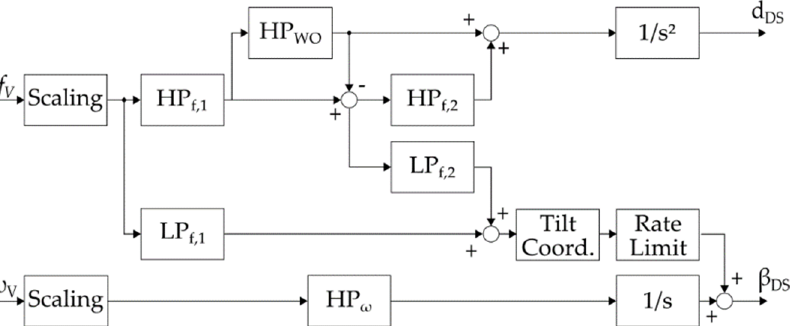
Figure 2. Compensation motion cueing algorithm (based on [3] (p. 34) (derived from [11] (p. 55))).